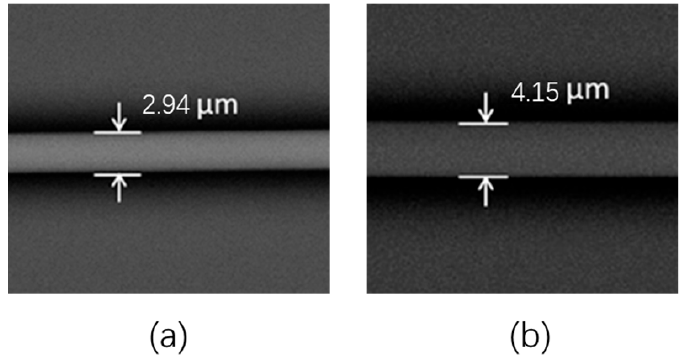
Figure 2. SEM photographs of the MF-BGs ( a ) without and ( b ) with the Teflon coating. The reflected wavelength λ B of a MF-BG can be expressed as [33] where n eff represents the RI of the fundamental mode and Λ is the grating pitch. From Equation (1), we know that λ B changes with n eff